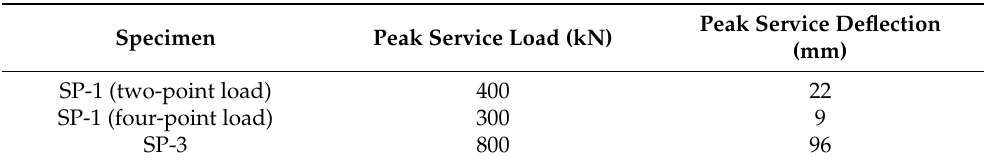
Table 5. Comparison of the load–deflection values for exterior girder of specimen SP-1 and specimen SP-3 under service loads.